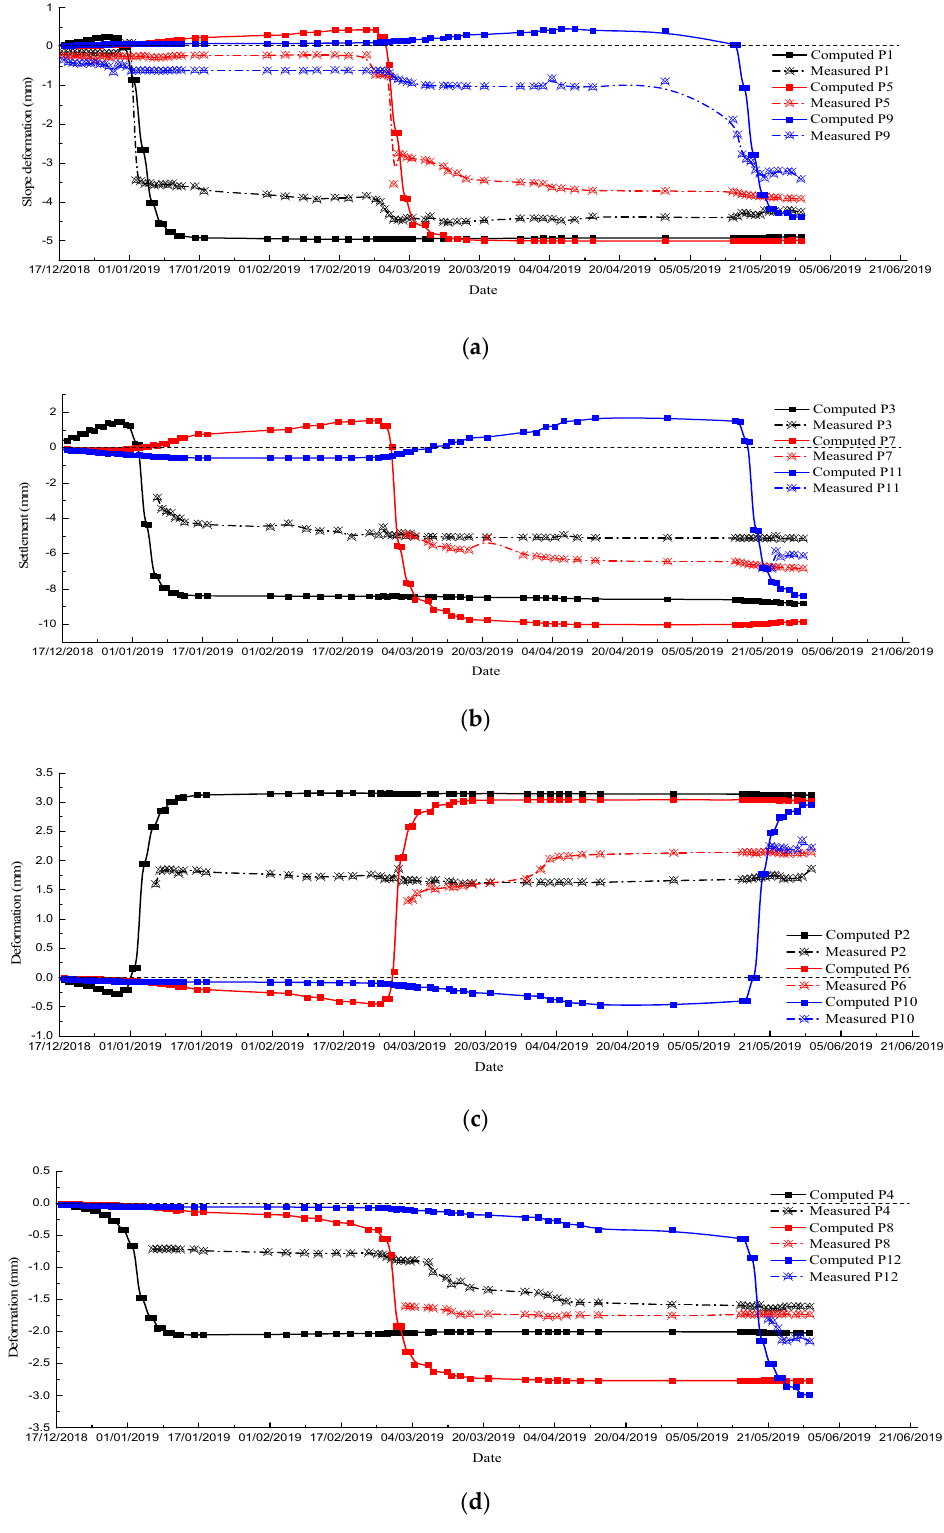
Figure 24. Deformation monitoring comparisons of the slope and the rocks surrounding the tunnel: ( a ) comparison of the time-history curves for the slope horizontal displacement, ( b ) comparison of the time-history curves for the tunnel vault vertical displacement, ( c ) comparison of the time-history curves for the tunnel left sidewall horizontal displacement, and ( d ) comparison of the time-history curves for the tunnel right sidewall horizontal displacement.